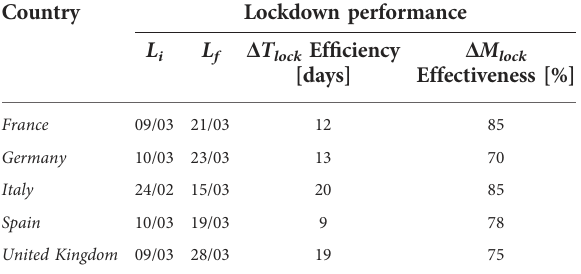
TABLE 4 Ef fi ciency and effectiveness of each country lockdown.